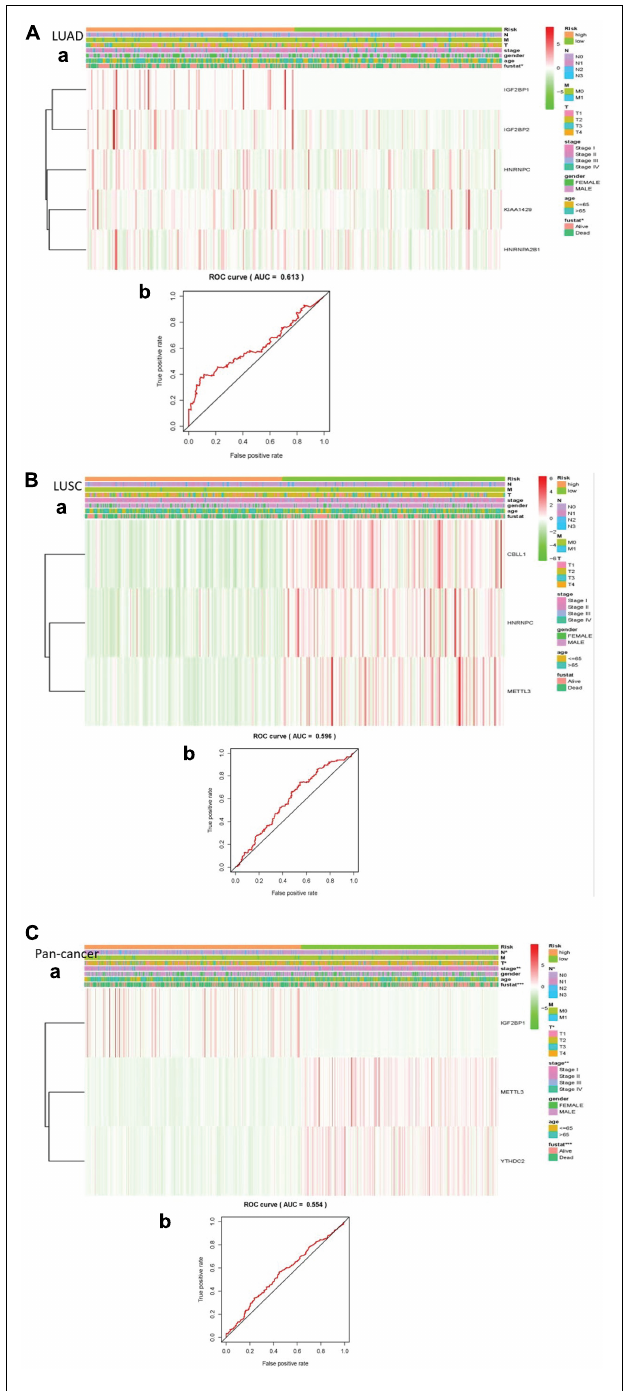
FIGURE 5 | Explain the relationship between risk score, m 6 A RNA methylation regulator expression level, clinical pathological characteristics, risk group, and overall survival rate. (A) LUAD; (B) LUSC; (C) pan-cancer. (a) Every ROC curve indicates the relationship between risk score and survival rate, reflecting the predictive efficiency of prognostic signatures. (b) Each heatmap shows the expression level of m 6 A RNA methylation regulator in lung cancer of two clusters. In addition, there are apparent differences in the distribution of clinical pathological characteristics between the two groups. When P < 0.001, the result is